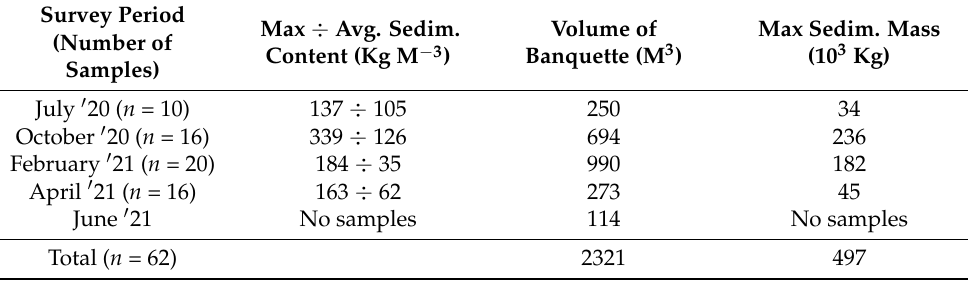
Figure 3. ( a ) Average digital elevation model of Mari Ermi beach barrier; ( b – f ) areas occupied by banquette deposits from July 2020 to June 2021 (from DGPS survey). Table 1. Volume of banquette deposited (m 3 ) and maximum sediment content (10 3 Kg) on Mari Ermi beach, from July 2020 to June